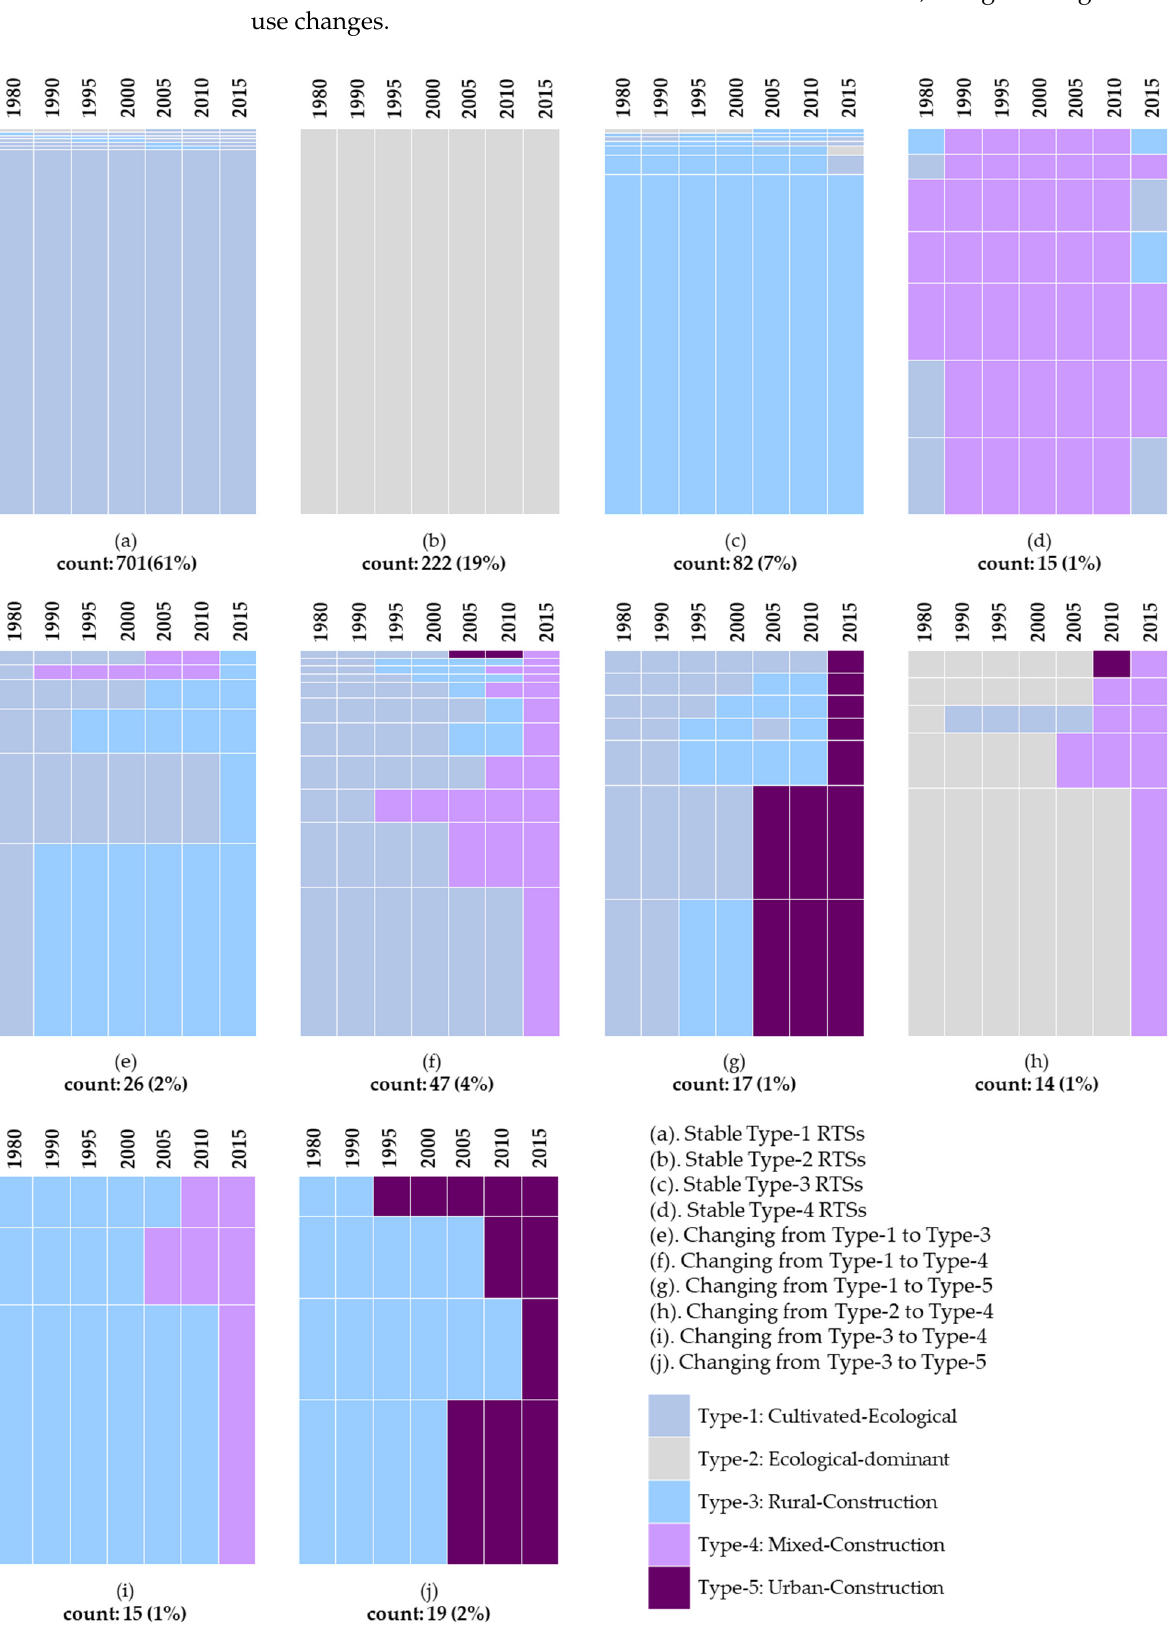
Figure 5. Distribution of land use sequences from 1980 to 2015 of ten types of RTSs.